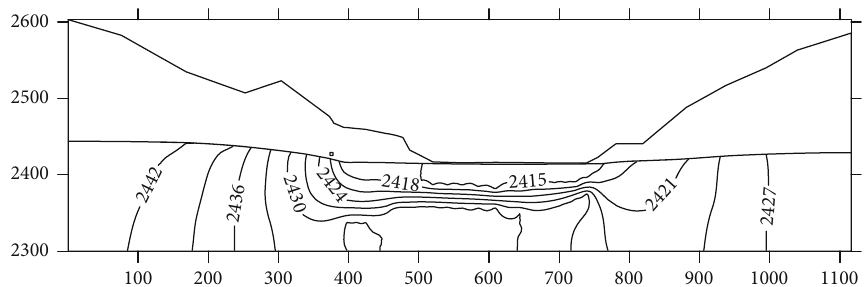
Figure 12: The isopotential distribution map of seepage fi eld about dam foundation (6-6pro fi le).